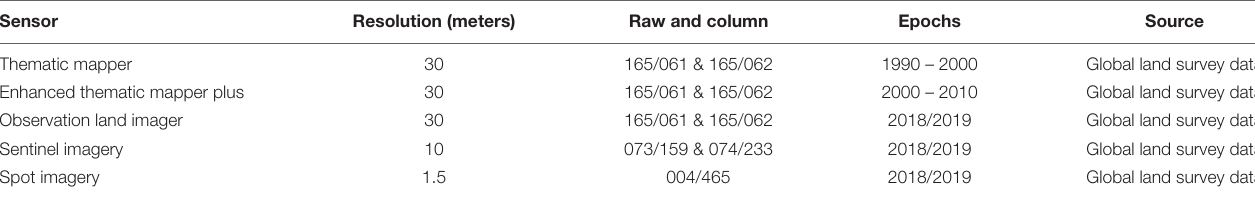
TABLE 1 | Information on global survey data used in the analysis and mapping of mangroves of Lamu.